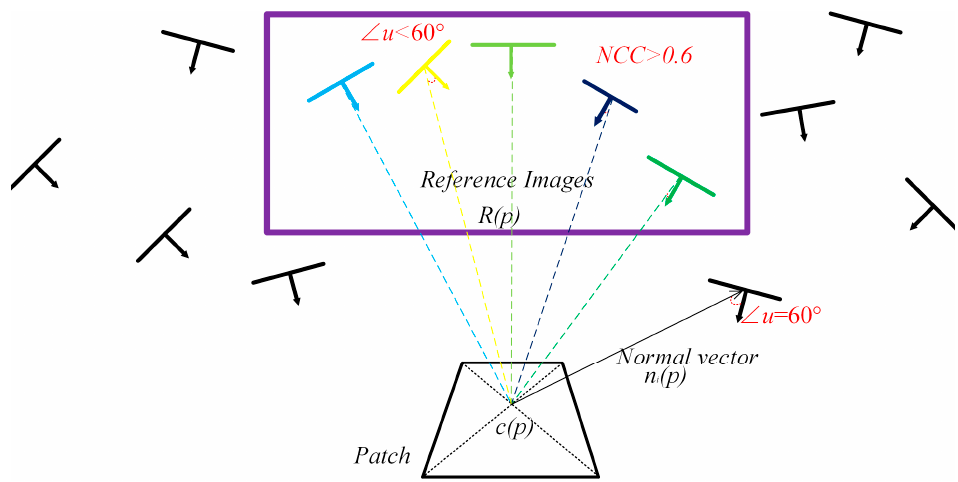
Figure 4. Selection of reference images.